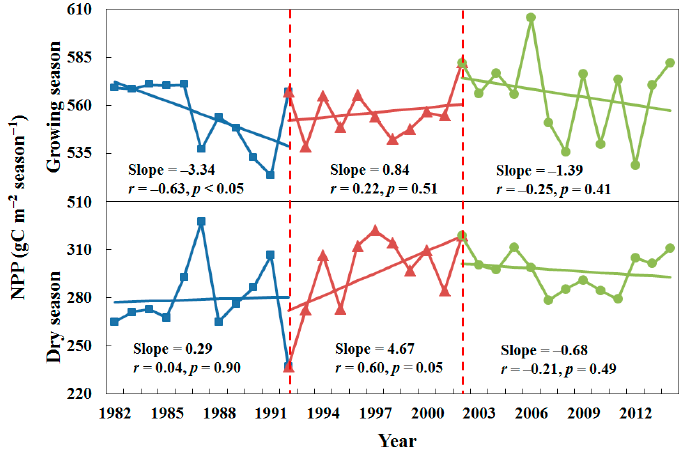
Figure 11. Inter-annual variation of NPP in the growing and dry seasons for the three stages. The growing season is from May to October, and the other six months in a year is the dry season.